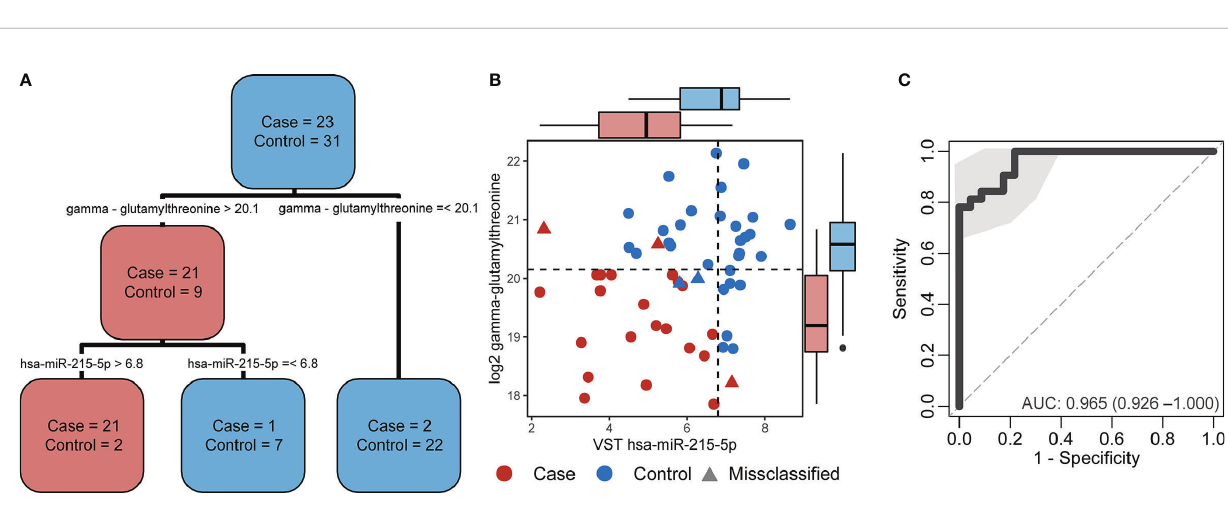
FIGURE 3 | Decision-tree algorithm results applied in the combined multi-omics data. (A) Decision-tree from the case and control classi fi cation. (B) Dot plot from variables selected by the decision-tree with dotted lines the decision thresholds. The boxplots parallel to X-axis show the hsa-miR-215-5p variance stabilizing transformation (VST) values by group and the boxplots parallel to the Y-axis show the log2 gamma-glutamylthreonine values by group. Cases are denoted in red and controls in blue. Circles indicate correctly classi fi ed cases and controls whereas triangles indicate misclassi fi cations. (C) Receiver operating characteristic (ROC) curve from the decision tree variables demonstrating the sensitivity, speci fi city, and area under the curve (AUC) of hsa-miR-215-5p and gamma-glutamylthreonine to discriminate participants by TB